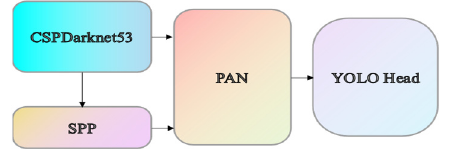
Figure 3. YOLOv4 network structure.